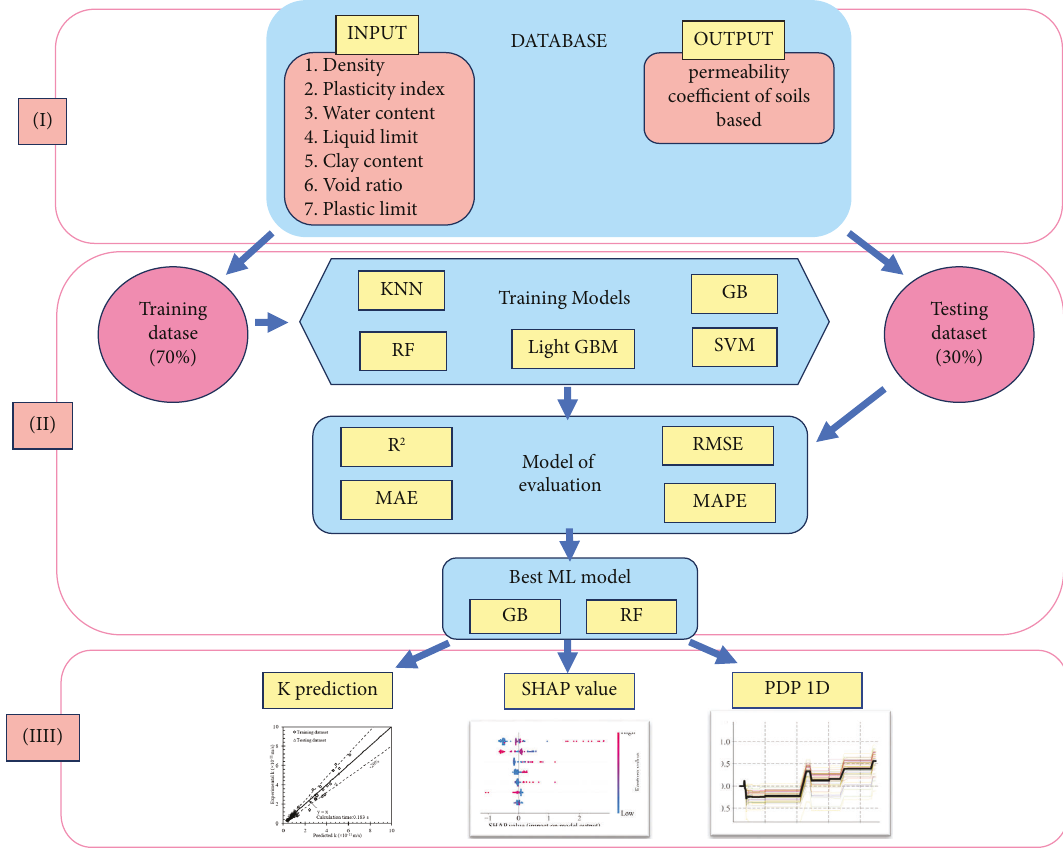
Figure 3: Methodology of